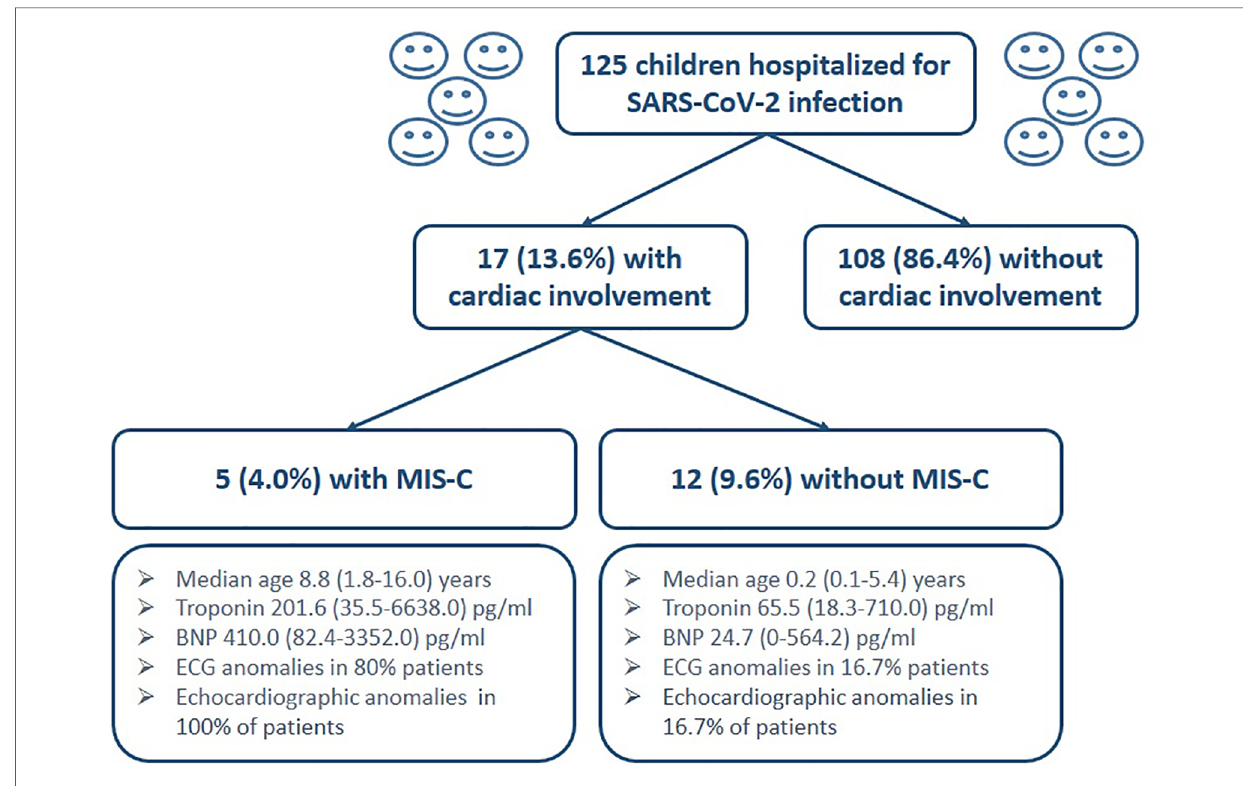
FIGURE 1 Flow-chart of children enrollment with main laboratory, electrocardiographic and echocardiographic fi ndings in the two